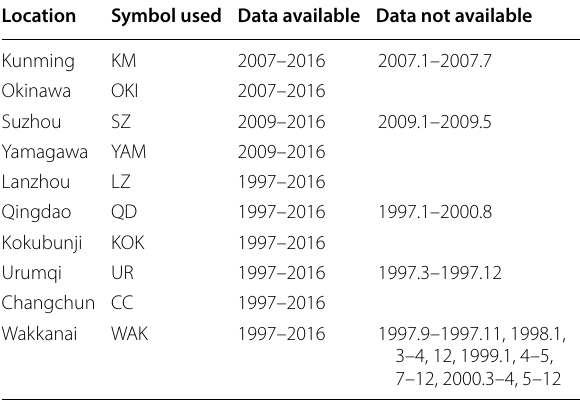
Table 1 Data set of 10 sites used in this study Location Symbol used Data available Data not available